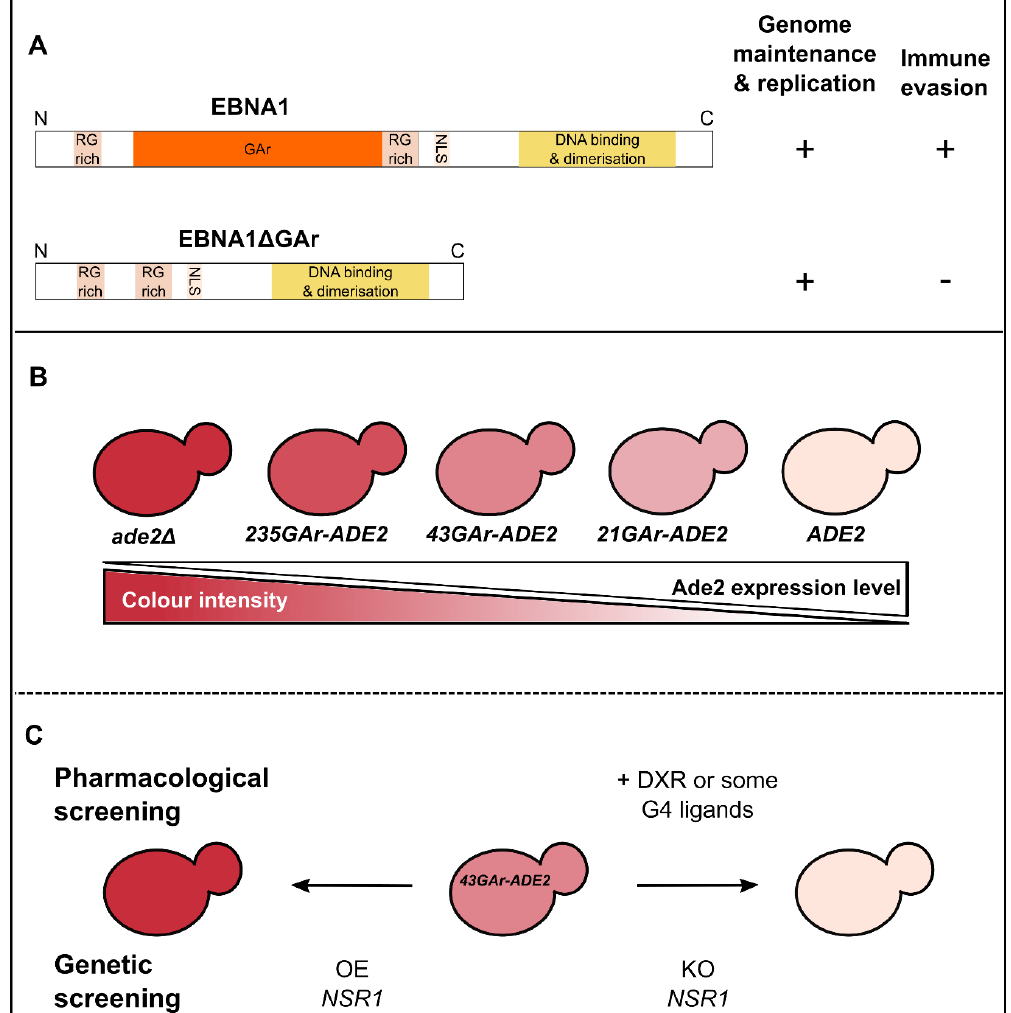
Figure 2. Rationale of the yeast-based assay for immune evasion of EBNA1 / EBV. ( A ) Schematic representation of EBNA1 and EBNA1 ∆ GAr proteins that highlights the crucial role of the central GAr (glycine-alanine repeats) domain for immune evasion: EBNA1 ∆ GAr is still able to fulfil its essential functions in viral genome maintenance and replication but does not evade the immune system. ( B ) Principle of the ADE2 reporter gene-based assay. Yeast cells that express a normal level of Ade2p (the product of the ADE2 gene) form white colonies whereas cells that do not express Ade2p ( ade2 ∆ cells) form red colonies due to the accumulation and consecutive oxidation of a by-product of the adenine biosynthesis pathway. Any intermediate level of Ade2 leads to pink colonies whose color intensity is inversely proportional to the Ade2p level. GAr domains of various lengths were fused to the ADE2 gene. As for EBNA1 in human cells, GAr inhibits the translation of its own mRNA in yeast. Please note that this e ff ect is length-dependent as in human cells, as the longest GAr tested (235GAr) leads to a strong inhibition of translation, giving rise to dark pink colonies, whereas the shortest GAr (21GAr) gives light pink colonies. For screening purpose, the 43GAr, which gives pink colonies, has been used. ( C ) Principle of the pharmacological and drug screenings based on the 43GAr-ADE2 yeast strain. Drugs able to interfere with GAr ability to inhibit translation, such as doxorubicin (DXR) [39] or various G-quadruplex ligands [41,54] lead to whiter colonies that express more 43GAr-Ade2p. In contrast, the overexpression (OE) of host cell genes involved in the GAr inhibitory e ff ect on translation, such as NSR1 that encodes the yeast nucleolin (NCL in humans), leads to redder colonies as the inhibition of 43GAr-ADE2 expression is exacerbated. Finally, the knockout (KO) of the NSR1 gene relieves the inhibitory e ff ect of GAr, leading to white